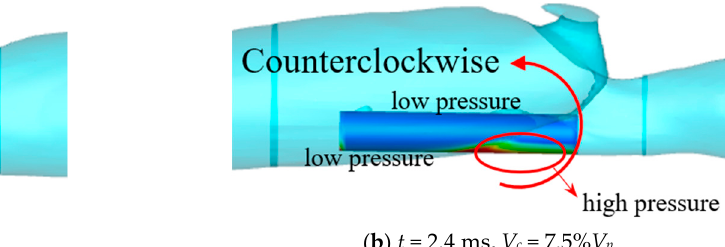
Figure 20. Change in the deflection angle α and the angular velocity with the time under different conditions.